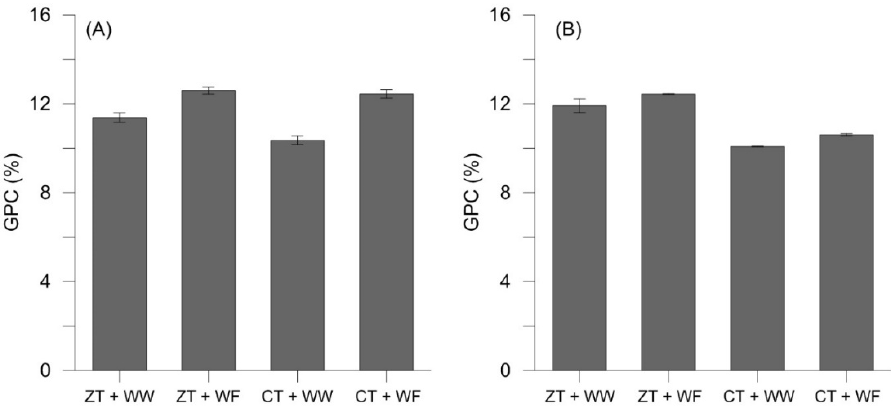
Figure 5. Grain protein content (GPC, %) as recorded for durum wheat at harvest in the 2016 ( A ) and 2017 ( B ) cropping seasons. Treatments: CT, conventional tillage; ZT, zero tillage; WW, durum wheat monocropping; WF, durum wheat-faba bean rotation. Data are averages ± standard errors of n = 3 independent